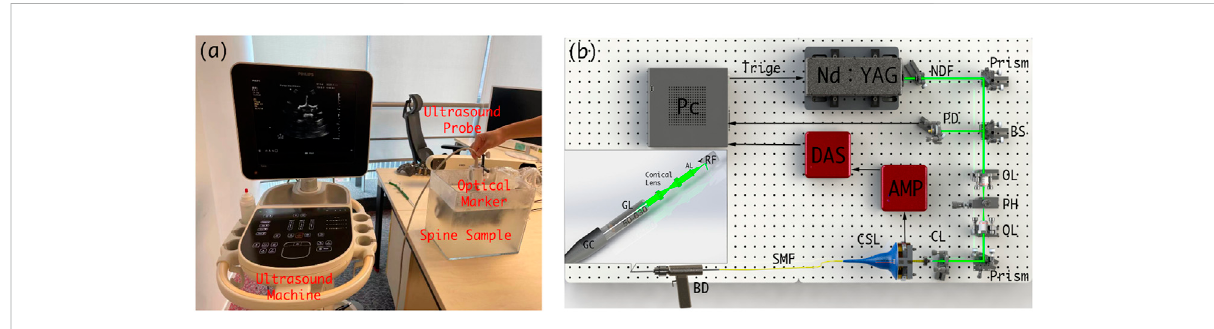
FIGURE 2 (A) Schematic diagram of the intra-operative US navigation system. (B) Schematic diagram of drilling probe. PC: personal computer, NDF: NeutralDensityFilter,PD:Photodiode,BS:beamsplit,OL:objectlens,PH:pinhole,CL:collimator,CSL:conductiveslip,SMF:singlemodel fi ber,BD: